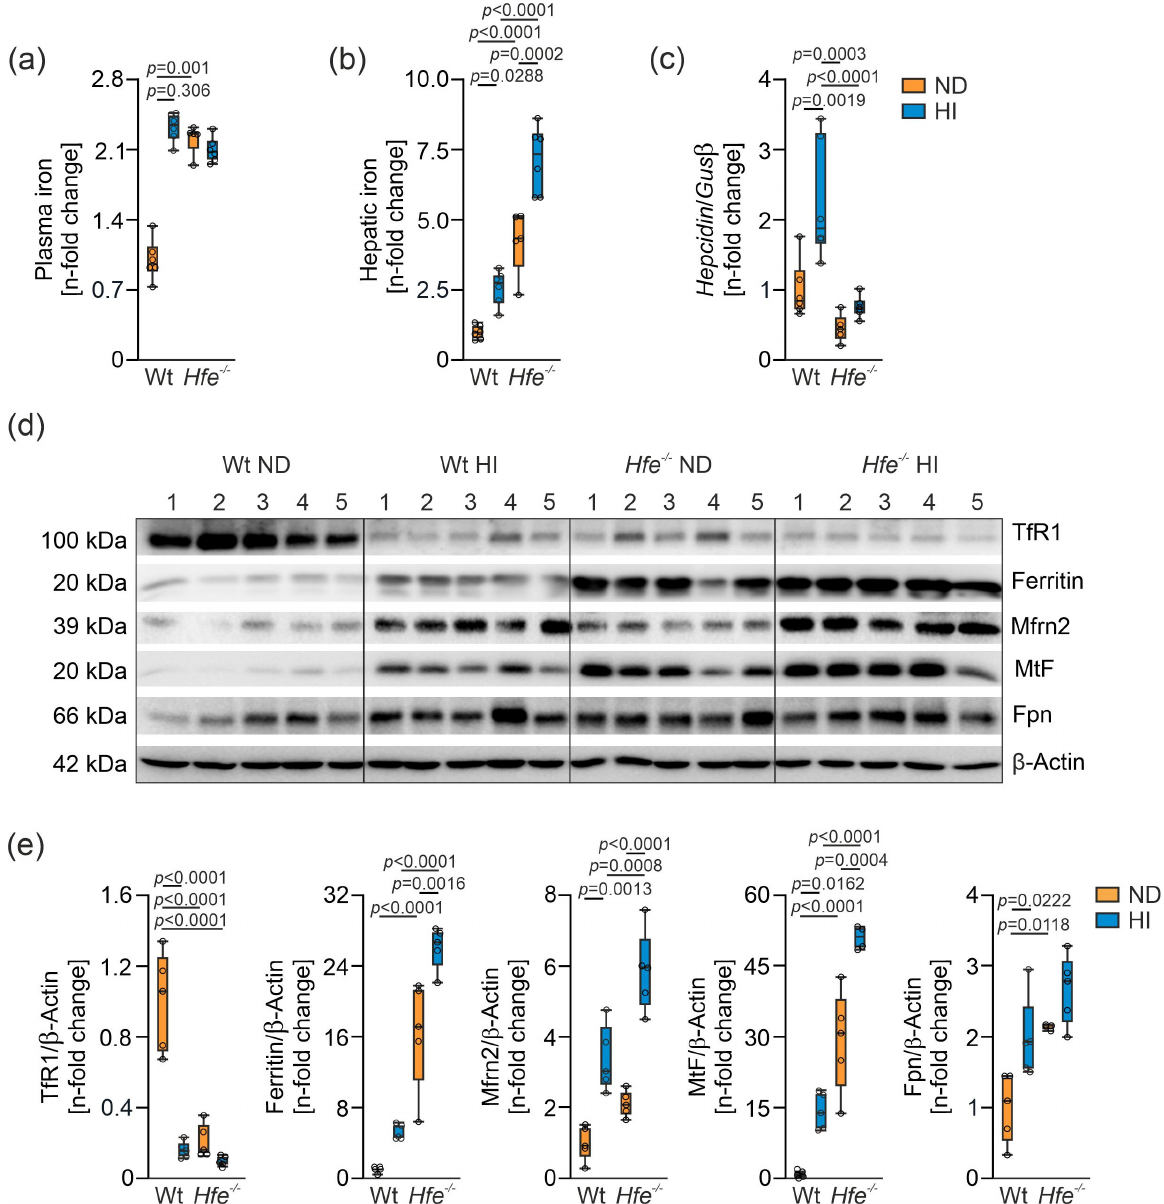
Figure 1. Impact of dietary and genetic iron overload in wildtype (Wt) and Hfe − / − mice on systemic and hepatic iron homeostasis. Wt and Hfe − / − mice were fed normal diet (ND) or high iron diet (HI) for two weeks. ( a ) Plasma iron concentration; ( b ) hepatic iron content; ( c ) hepatic hepcidin mRNA expression; ( d ) Western blots of proteins involved in cellular and mitochondrial iron metabolism (transferrin receptor 1 (TfR1), ferritin, mitoferrin 2 (Mfrn2), mitochondrial ferritin (MtF), ferroportin (Fpn)) along with ( e ) densitometric quantification of Western blots. β -Actin served as loading control. All results were obtained from snap-frozen samples. n = 5–6 mice per group. Values are depicted as n-fold change of Wt ND. Kruskal–Wallis test: ( a ) p = 0.0014; two-way ANOVA: ( b ) diet, F (1,19) = 36.00, p < 0.0001; genotype, F (1,19) = 108.8, p < 0.0001; diet X genotype, F (1,19) = 3.062, p = 0.0963; ( c ) diet, F (1,19) = 13.74, p = 0.0015; genotype, F (1,19) = 23.60, p = 0.0001; diet X genotype, F (1,19) = 5.067, p = 0.0364; ( e ) TfR1—diet, F (1,16) = 48.86, p < 0.0001; genotype, F (1,16) = 39.44, p < 0.0001; diet X genotype, F (1,16) = 28.76, p < 0.0001; Ferritin—diet, F (1,16) = 21.44, p = 0.0003; genotype, F (1,16) = 147.3, p < 0.0001; diet X genotype, F (1,16) = 3.433, p = 0.0825; Mfrn2—diet, F (1,16) = 72.74, p < 0.0001; genotype, F (1,16) = 25.05, p = 0.0001; diet X genotype, F (1,16) = 3.673, p = 0.0733; MtF—diet, F (1,15) = 39.71, p < 0.0001; genotype, F (1,15) = 137.2, p < 0.0001; diet X genotype, F (1,15) = 2.387, p = 0.1432; Fpn—diet, F (1,15) = 12.19, p = 0.0033; genotype, F (1,15) = 17.98, p = 0.0007; diet X genotype, F (1,15) = 1.091, p = 0.3129. Values are shown as median ± interquartile range. The exact p -values are indicated in the